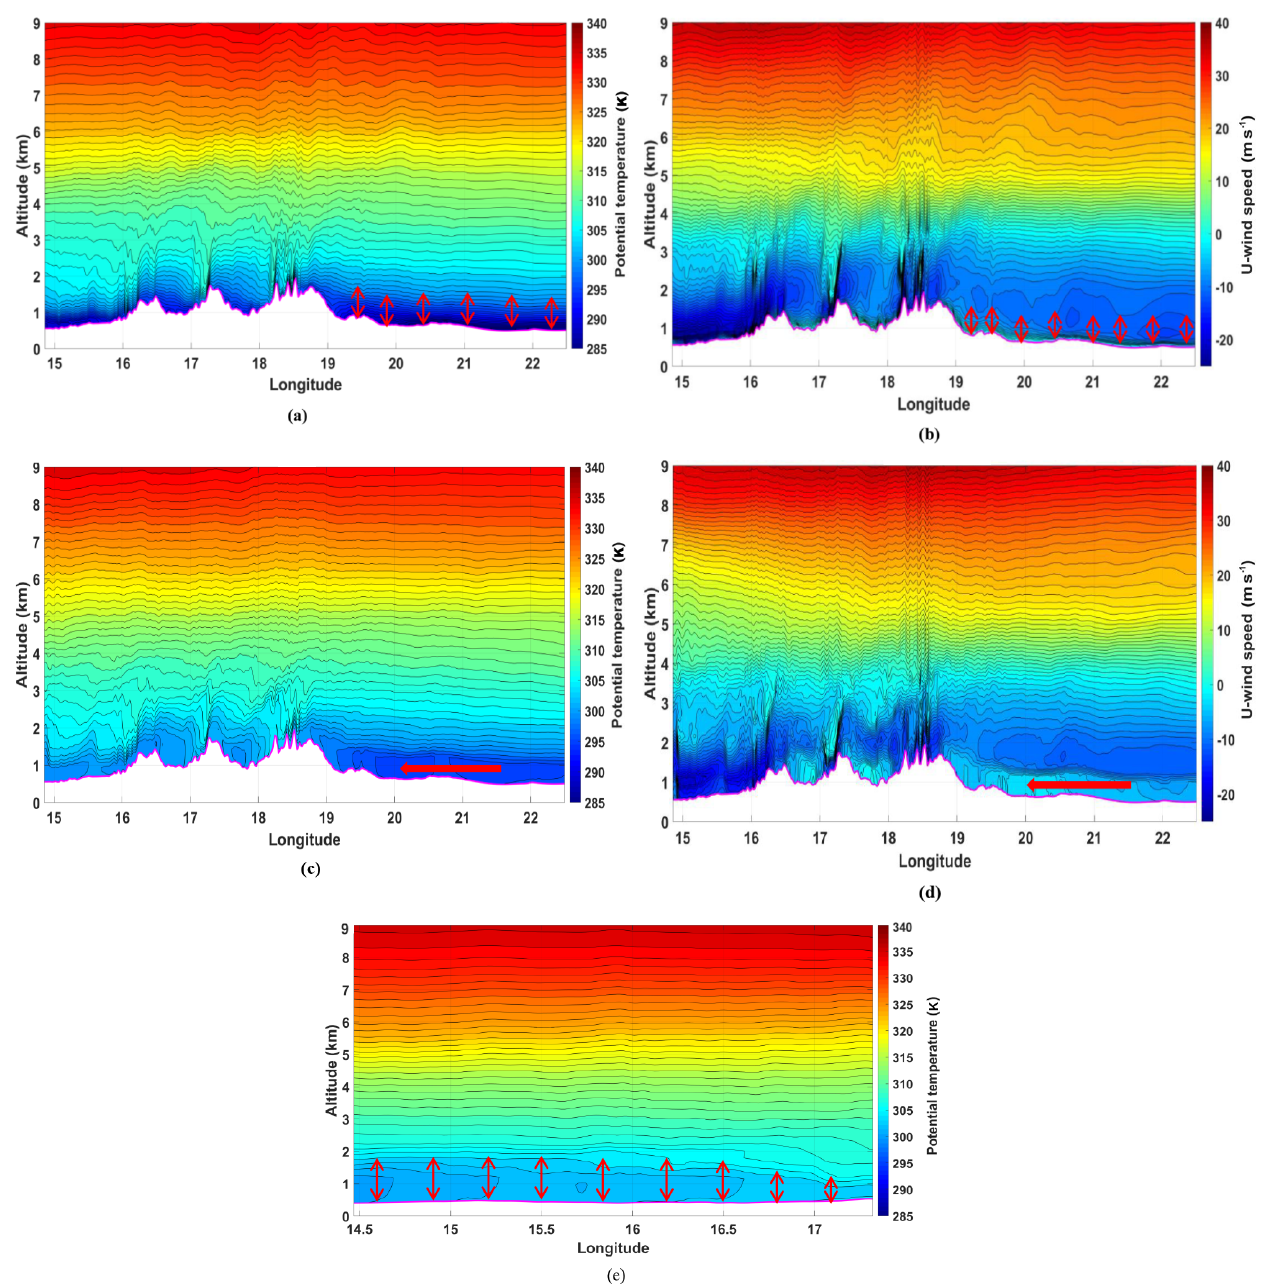
Figure 11. (a) Vertical cross sections of potential temperature at 21.57 ◦ N on 07:00UTC 8 December 2011 (2km resolution WRF product). Red arrows (up and down) indicate the depth of region of possible stability of the atmosphere. (b) Vertical cross sections of u -wind speed at 21.57 ◦ N on 07:00UTC 8 December 2011 (2km resolution WRF product). Red arrows (up and down) indicate blocking of the air. (c) Vertical cross sections of potential temperature at 21.57 ◦ N on 11:00UTC 8 December 2011 (2km resolution WRF product). Red arrow indicates Kelvin wave (cold air surge). (d) Vertical cross sections of u -wind speed at 21.57 ◦ N on 11:00UTC 8 December 2011 (2km resolution WRF product). Red arrow indicates Kelvin wave. (e) Vertical cross sections of potential temperature at 18.89 ◦ N on 15:00UTC 8 December 2011 (2km resolution WRF product). Red arrows (up and down) indicate warm air column of vertical stretch of isentropes.